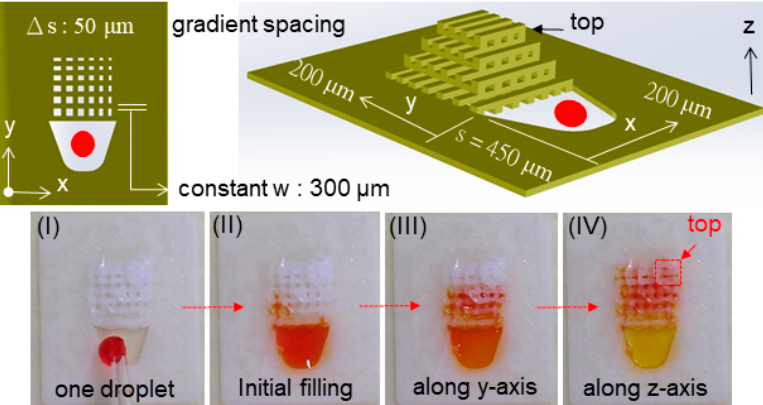
Figure 9. Demonstration of one droplet ( I ) into a 3D printed grid structure with a constant line width (w = 300 µ m) and gradient spacing (s = 200–450 µ m, ∆ s = 50 µ m) using a pipette: continuous motion of capillary flow through the initial filling ( II ), secondary transport along the y-axis ( III ), and final rise along the z-axis ( IV ) eventually reaching the top.